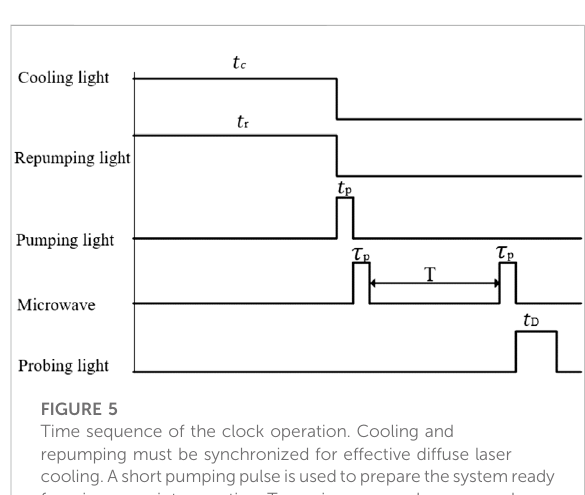
FIGURE 5 Time sequence of the clock operation. Cooling and repumping must be synchronized for effective diffuse laser cooling.Ashortpumpingpulseisusedtopreparethesystemready formicrowaveinterrogation. Twomicrowavepulsesareused as Ramsey interactions with cold atoms, and the linewidth of the Ramsey fringe is determined by the separation of two pulses. The probing light is used to detect the atomic population after microwave interactions, which is directly related to themicrowave frequency.